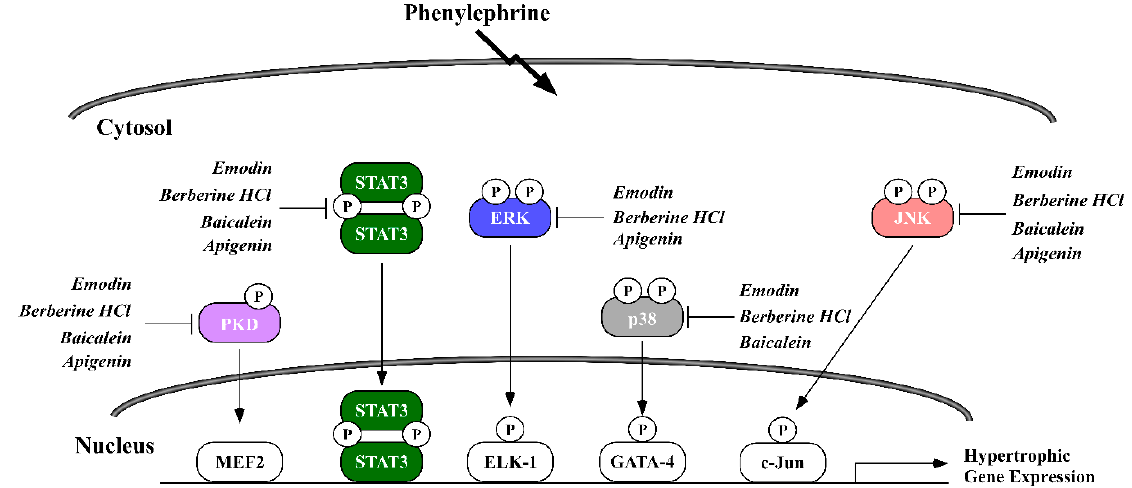
Figure 7. Model showing which signaling pathways were targeted by phytochemical treatment.